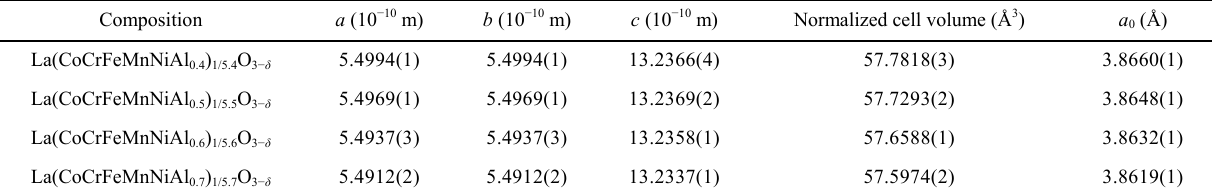
Note: a 0 is the normalized quasi-cubic cell